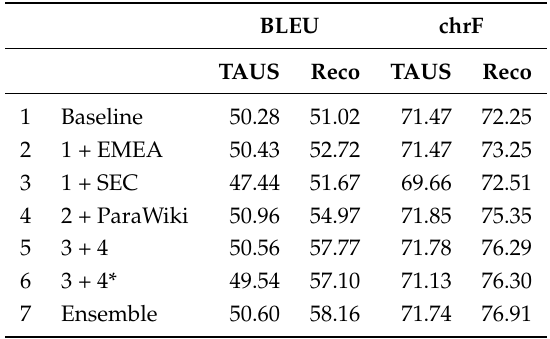
Table 6. The Italian-to-English NMT systems. SEC: Sketch Engine